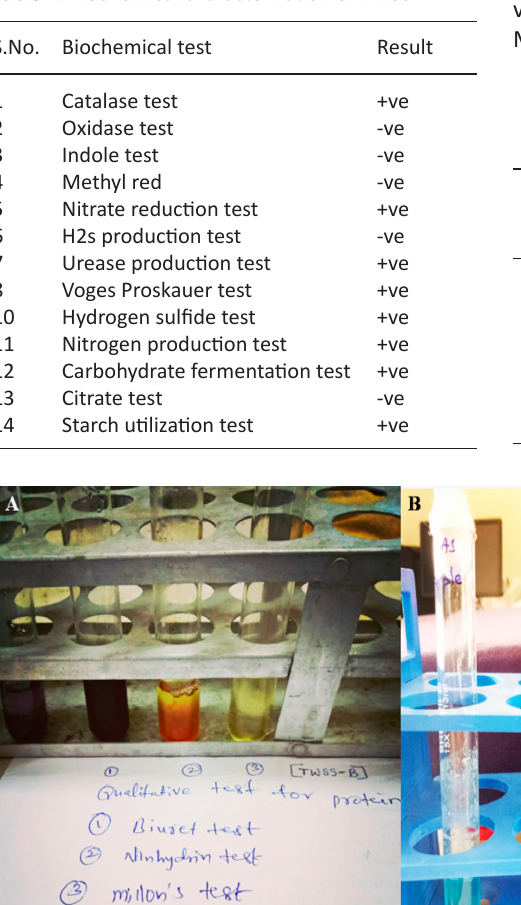
Table 2. Biochemical characterization of TWSS-P-2